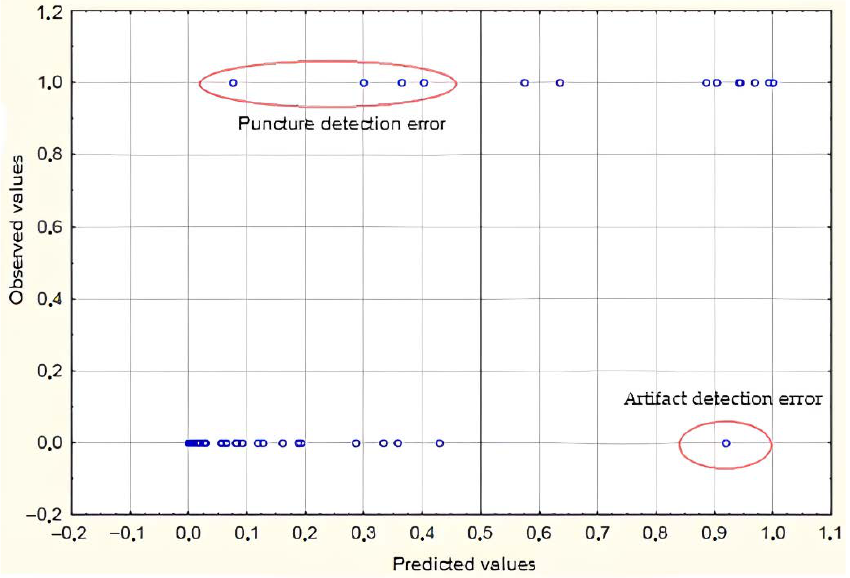
Figure 9. Training a logistic regression model on a test sample.